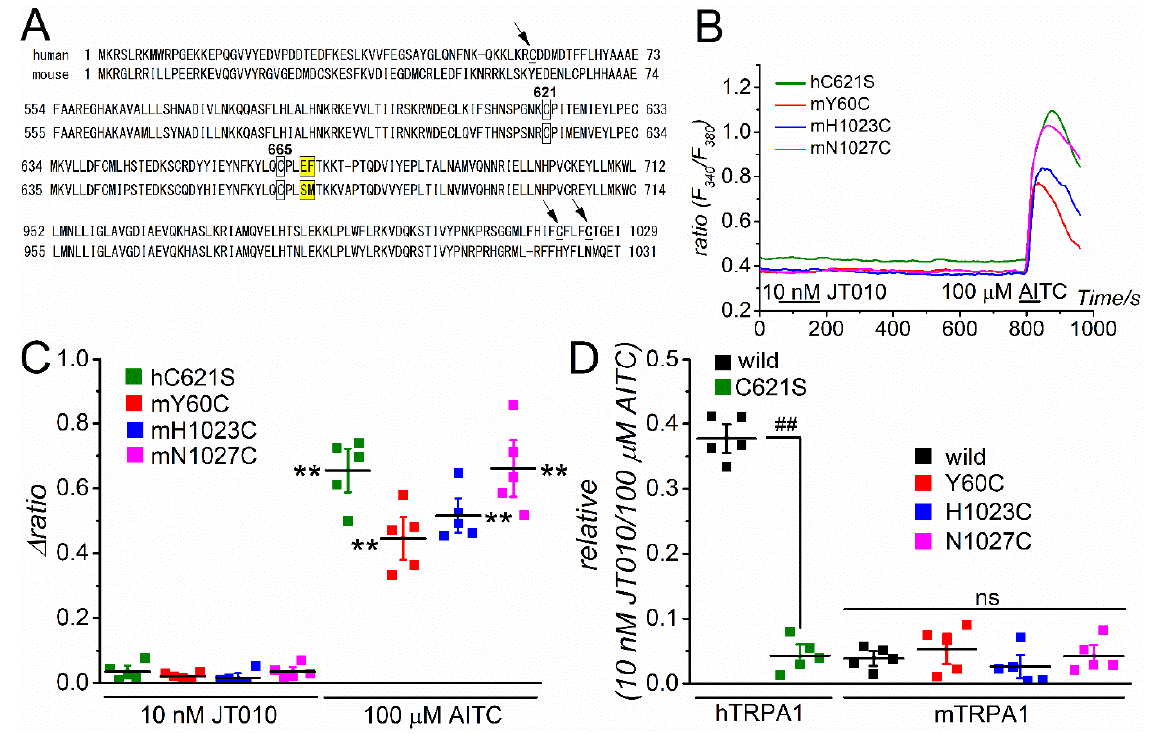
Figure 4. Comparison of JT010-induced TRPA1 response among mutants of N- and C-terminal cysteine residues of hTRPA1 and mTRPA1. ( A ) Alignment of amino acid sequence between hTRPA1 and mTRPA1. C621 and C665 in hTRPA1 (homologous to mTRPA1 C622 and C666) shown by boxes indicate critical cysteines for electrophilic TRPA1 agonist modification. Bold and underlined letters (C59, C1021, C1025 in human, indicated by an arrow) show cysteines substituted in mutant mTRPA1 (Y60C, H1023C, N1027C), whose effect was examined. Yellow color boxes indicate potential critical amino acids for JT010-sensitivity, whose importance is examined in Figures 5 and 6. ( B – D ) Ca 2+ responses of mutant hTRPA1 with C621S mutation and mutant mTRPA1s with Y60C, H1023C, and N1027C mutations to 10 nM JT010. To confirm the channel expression, 100 μ M AITC was applied at the end of the experiment. Each representative Ca 2+ response was superimposed ( B ) and the peak JT010- and AITC-induced Ca 2+ response ( Δ ratio) is summarized ( C , five independent experiments). Paired Student’s t -test: ** p < 0.0001, ** p = 0.00092, ** p < 0.0001, and ** p = 0.00064 for hC621S, mY60C, mH1023C, and mN1027C, respectively ( D ) Ca 2+ response to JT010 was normalized with that to AITC and is summarized. The responses of wild hTRPA1 and mTRPA1 were also included as a comparison (the same data set as Figure 1). Unpaired Student’s t -test: ## p < 0.0001. The ‘ns’ shows no significance by the Tukey–Kramer test. Vertical bars = SEM.